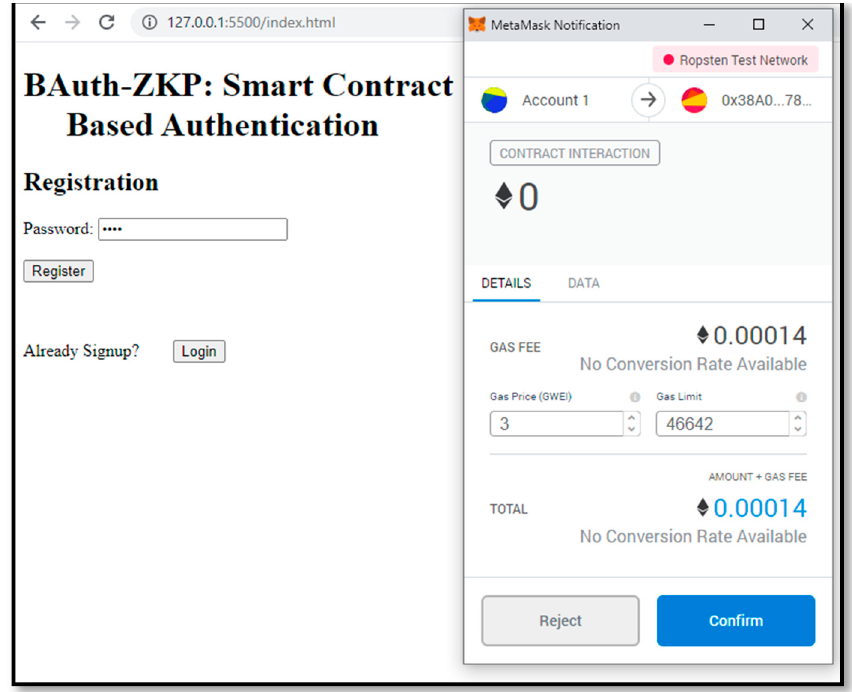
Figure 12. Proof of concept registration and login webpages of BAuth-ZKP.